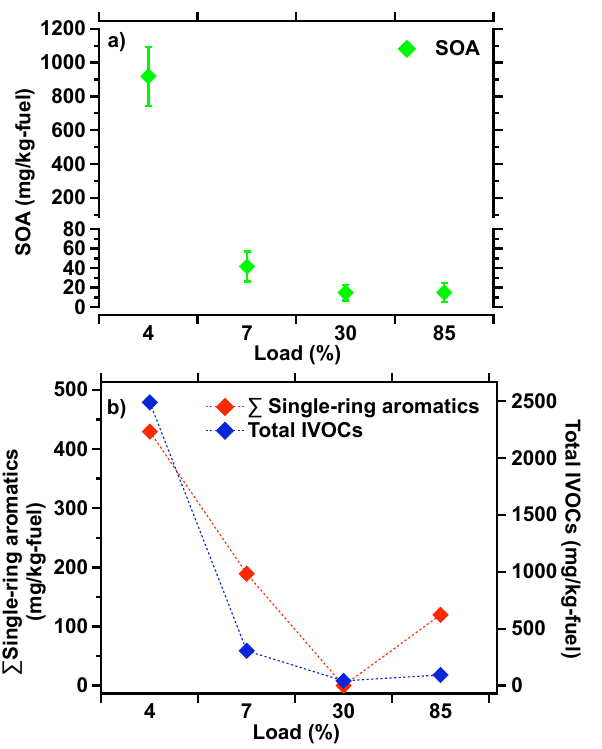
Fig. 8. (a) Average AMS mass spectra of primary and aged OA (b) time evolution of AMS f 44 and f 57 . Data are averages of all experiments conducted at 4% load. Only undenuded (no TD) data are